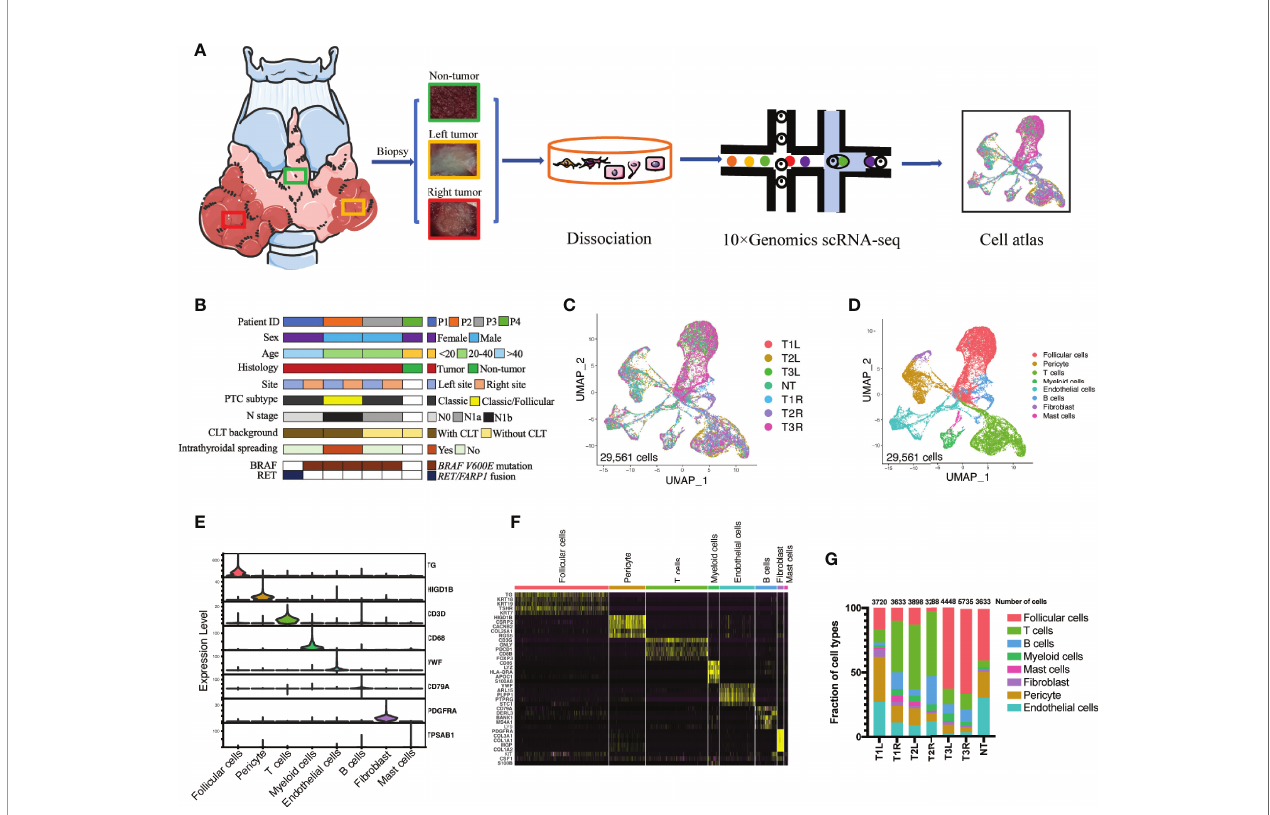
FIGURE 1 | Single-cell transcriptomic pro fi ling of bilateral papillary thyroid carcinoma (PTC). (A) Schematic diagram of the single-cell transcriptomic pro fi ling of non-tumor (NT) thyroid tissue ( n = 1) and bilateral PTC ( n = 3) across disease stages. (B) Clinical and pathological characteristics of the patient cohort with the distribution of mutation events. (C) All PTC and NT thyroid tissues were well represented in the dataset. Uniform manifold approximation and projection (UMAP) for dimension reduction colored by tissue origin (total number of cells = 29,561). (D) Single-cell RNA sequencing (scRNA-seq) analysis revealed eight known cell lineages (cell populations labeled; total number of cells = 29,561). (E) Violin plots showing the smoothed expression distributions of canonical marker genes in the eight cell lineages. (F) Heatmap of the top 5 signature genes in each cell lineage. (G) Proportion of each cell lineage in seven samples. T1L and T1R : PTC from the left lobe and right lobe of patient P1, respectively. T2L and T2R : PTC from the left lobe and right lobe of patient P2, respectively. T3L and T3R : PTC from the left lobe and right lobe of patient P3,